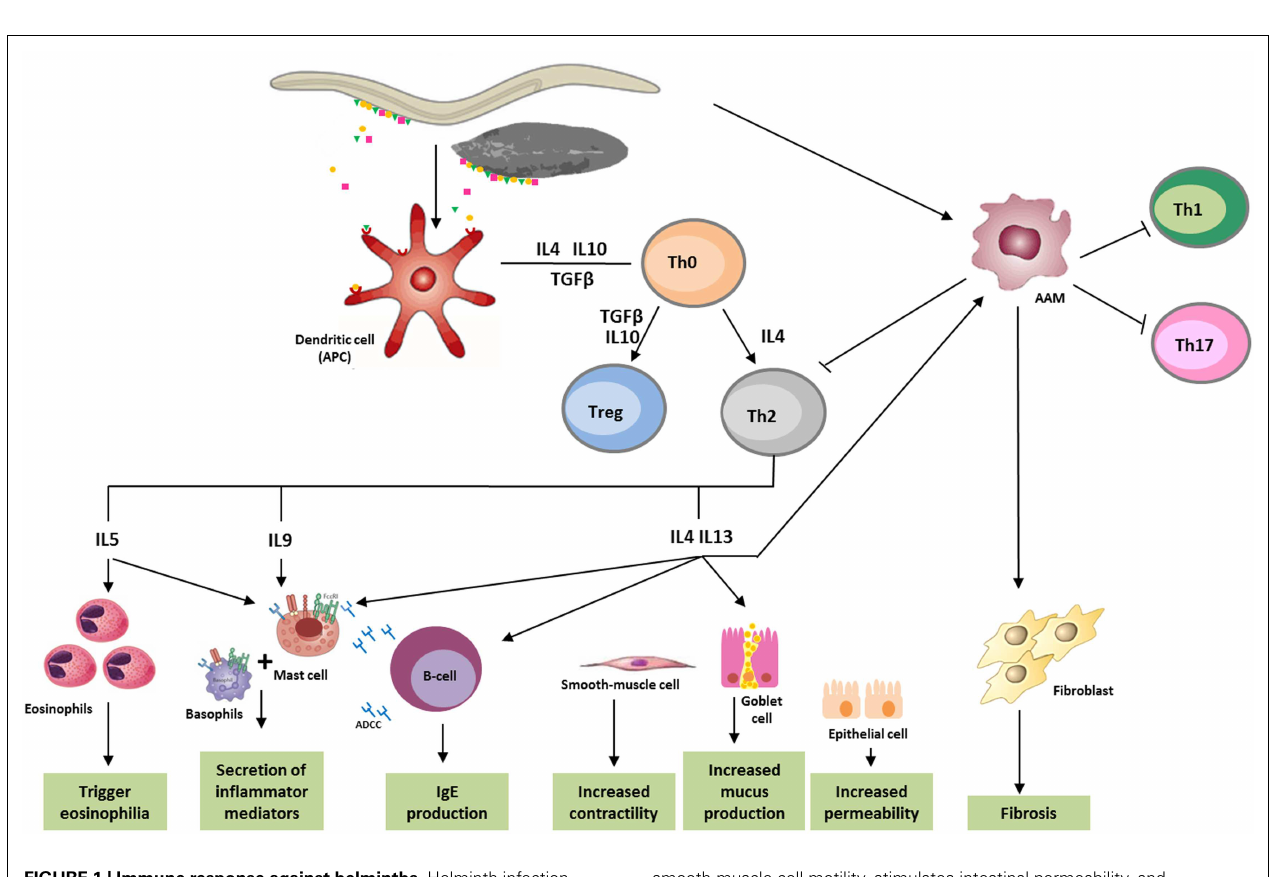
FIGURE 1 | Immune response against helminths . Helminth infection mainly leads toTh2 response, involving immune system cells and cytokines. Parasite antigens are recognized by dendritic cells, which in turn act as antigen-presenting cells (APC) forT cells, initiating parasites expulsion. Releasing of cytokines like IL-5, which triggers eosinophilia, and IL-4, IL-9, IL-13, as well as IgE, which bind to the FceRI (high-affinity Fc receptors for IgE), lead to the activation of basophils and mast cells, and cause secretion of inflammatory mediators. IL-4 and IL-13 increase